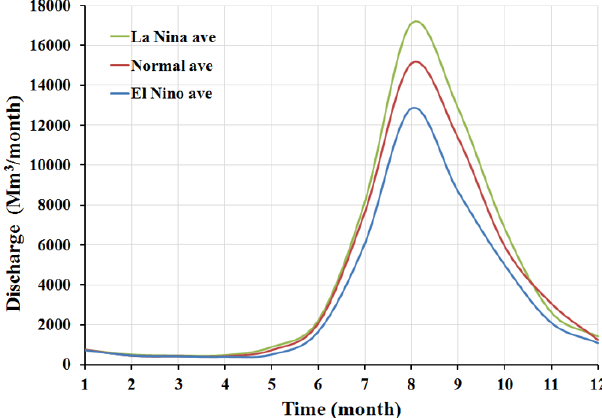
Fig. 4. Monthly discharge at Eldiem station averaged during El